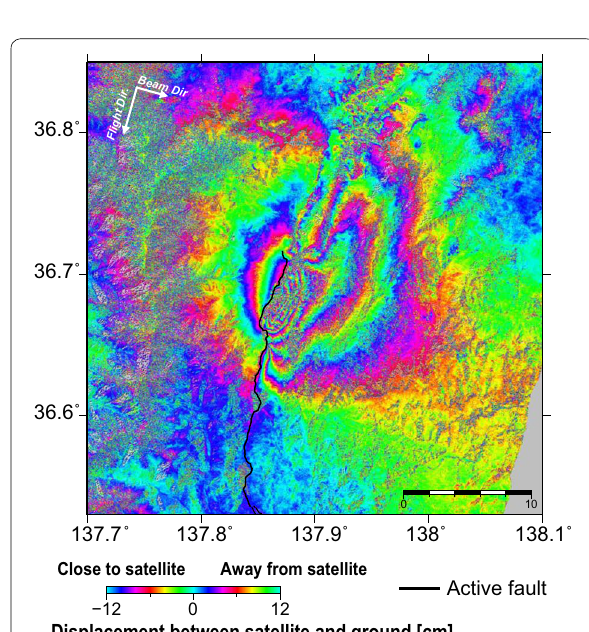
Fig. 3 Surface displacement observed after the 2014 Northern Nagano earthquake by the interferometric synthetic aperture radar. The used observation pair is October 2, 2014, and November 27, 2014. A clear surface offset is observed along parts of the previously mapped active fault trace (black line) (Sawa et al. 1999) on the south- ern half of the focal